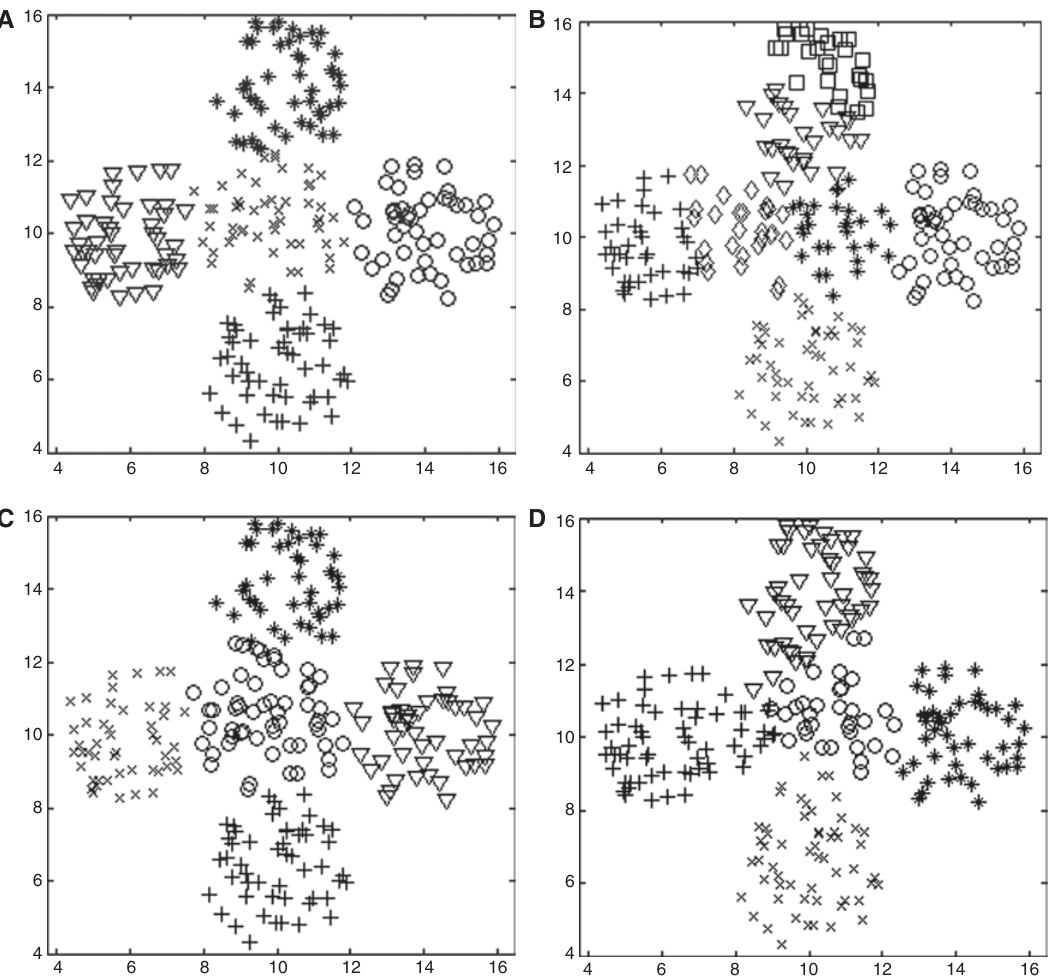
Figure 5: (A) Clustered Spherical_5_2 after the Application of KM for K = 5. (B) Clustered Spherical_5_2 after the Application of KM for K = 7. (C) Clustered Spherical_5_2 after the Application of FCM for K = 5. (D) Clustered Spherical_5_2 after the Application of MHSC for K =